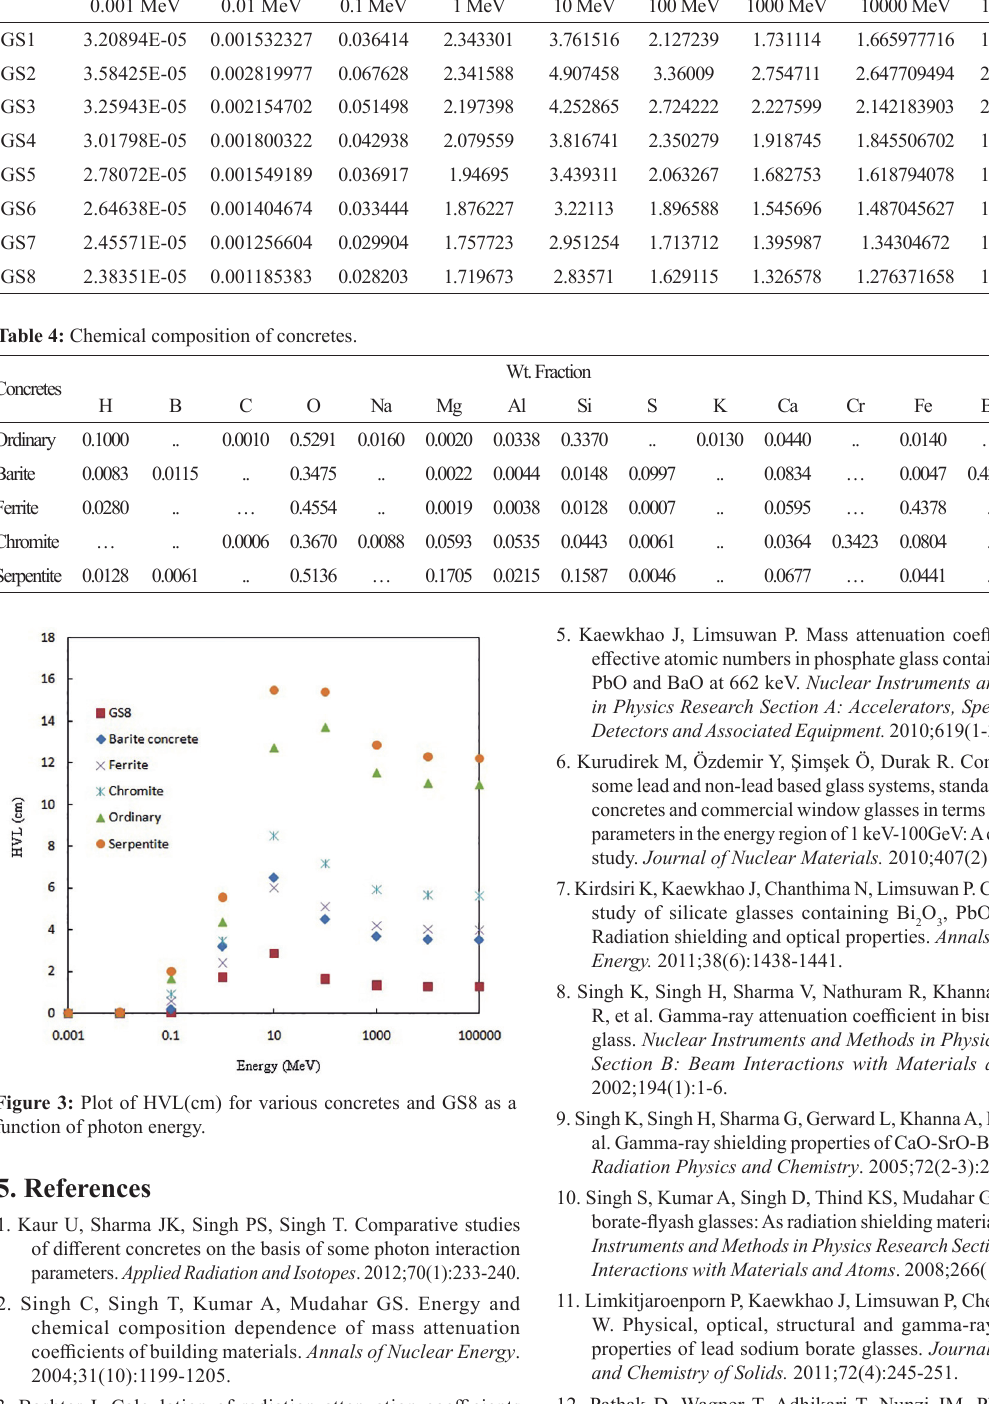
Table 3: HVL values for prepared glass samples at different energies. Sample